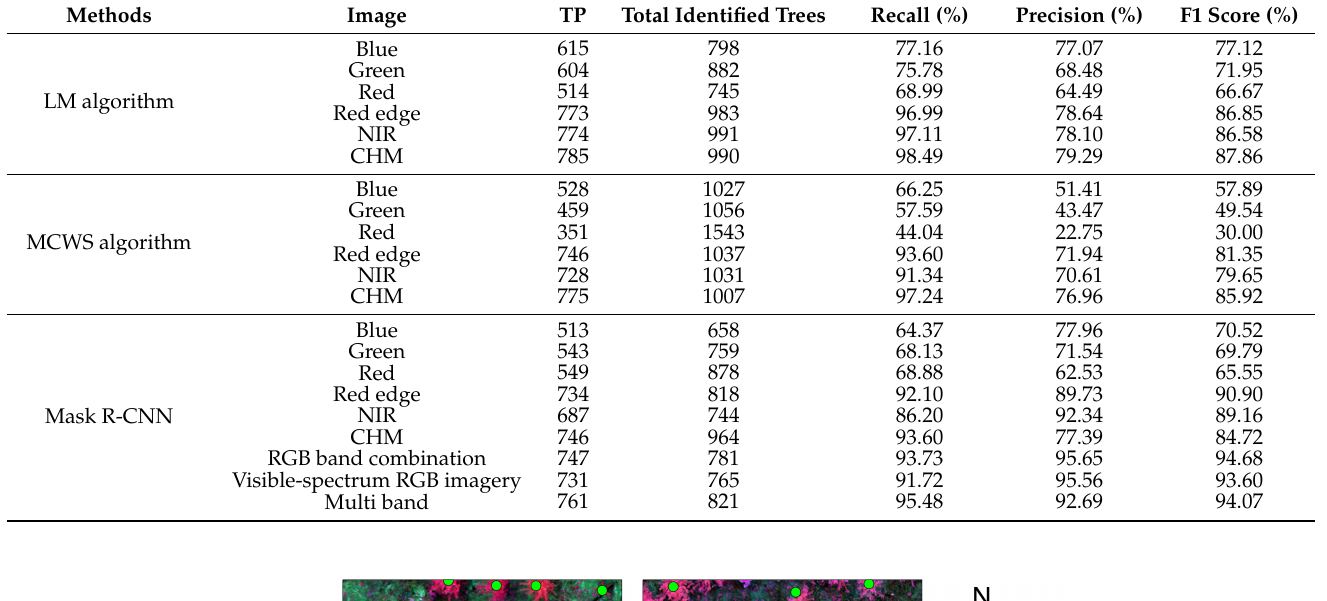
Table 2. Images used for tree identification using the LM algorithm, MCWS algorithm, and Mask R-CNN.